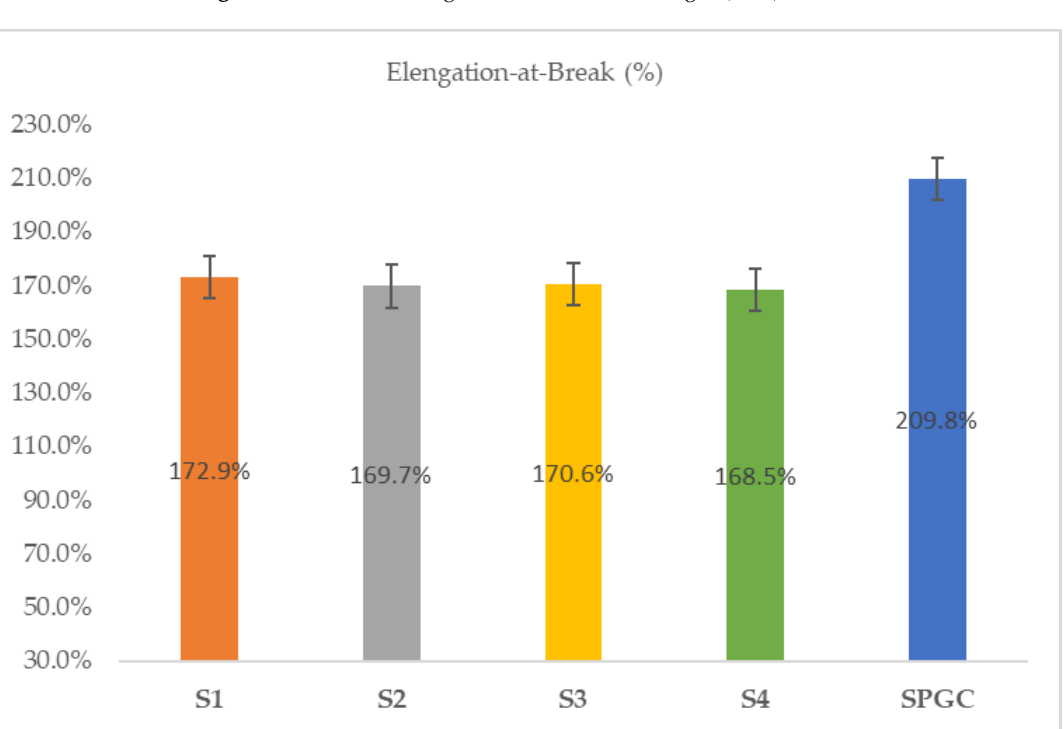
Figure 10. Effect of nZnO content on the elongation-at-break of the wound dressings .